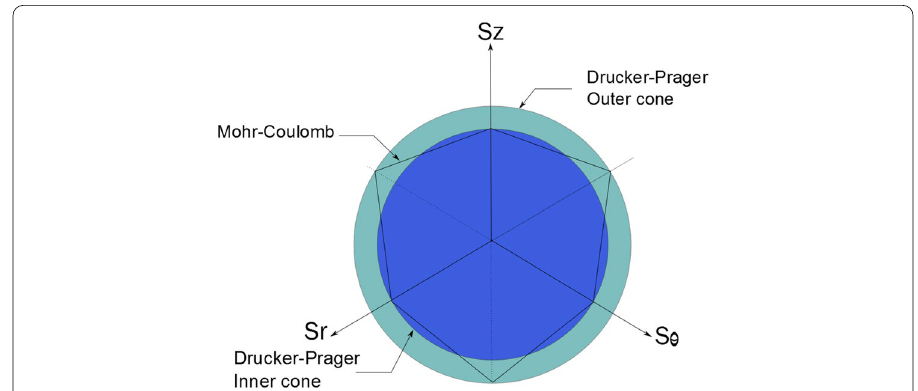
Fig. 3 Mohr–Coulomb and Drucker–Prager criteria on the octahedral plane